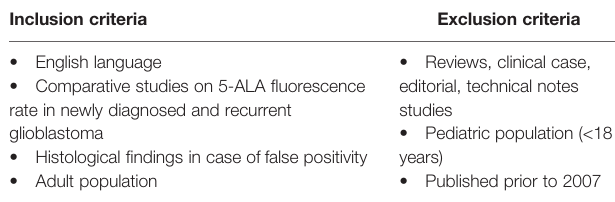
TABLE 1 | Inclusion and exclusion